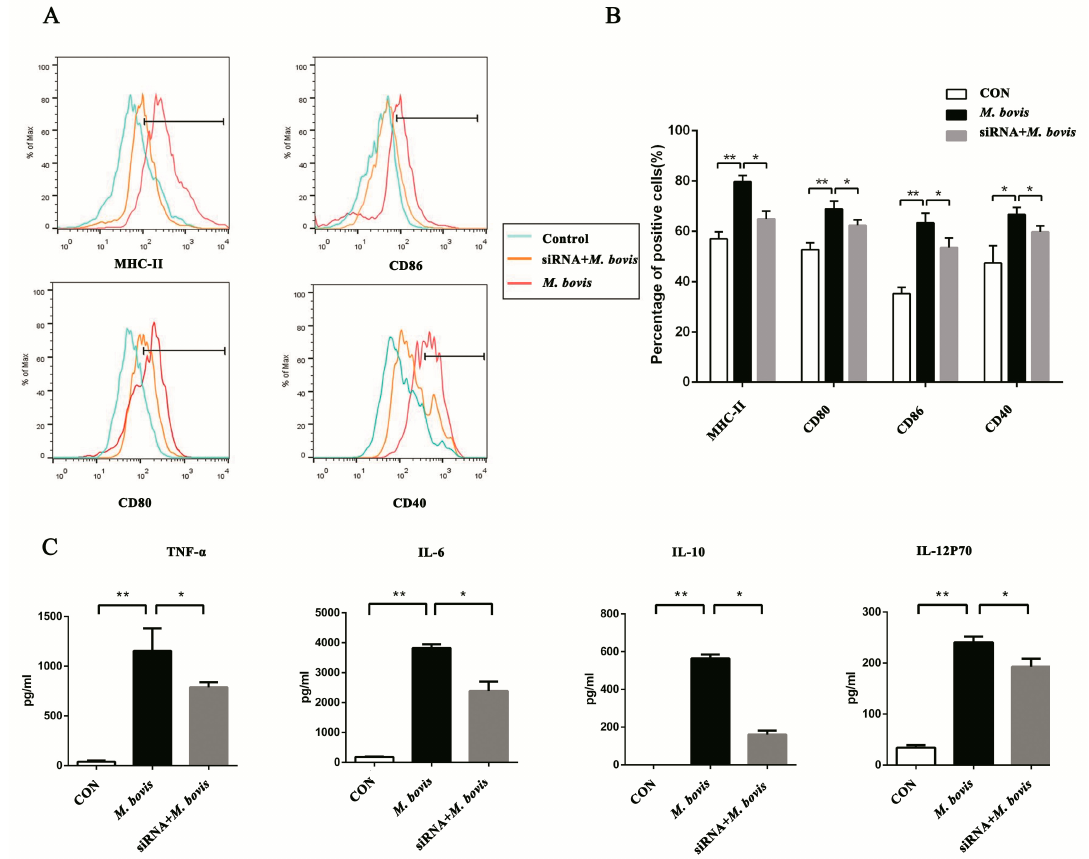
Figure 2. The cGAS pathway promotes the maturation and activation of BMDCs. ( A ) The cell surface markers of CD40, CD80, CD86, and MHC class II were analyzed by flow cytometry in BMDCs transfected with siCon or sicGAS and then infected for 24 h with M. bovis (MOI 5). The CD11c marker was used to set the gate for flow cytometric analysis. ( B ) The positive cell rate of surface markers in each group was calculated, and histograms were generated by FlowJo software. ( C ) Culture supernatants were collected after 24 h; the expressions of TNF- α , IL-6, IL-10, and IL-12p70 were assayed by ELISA. All data are expressed as mean ± SD, (* p < 0.05; ** p < 0.01; n.s.: no statistical significance).